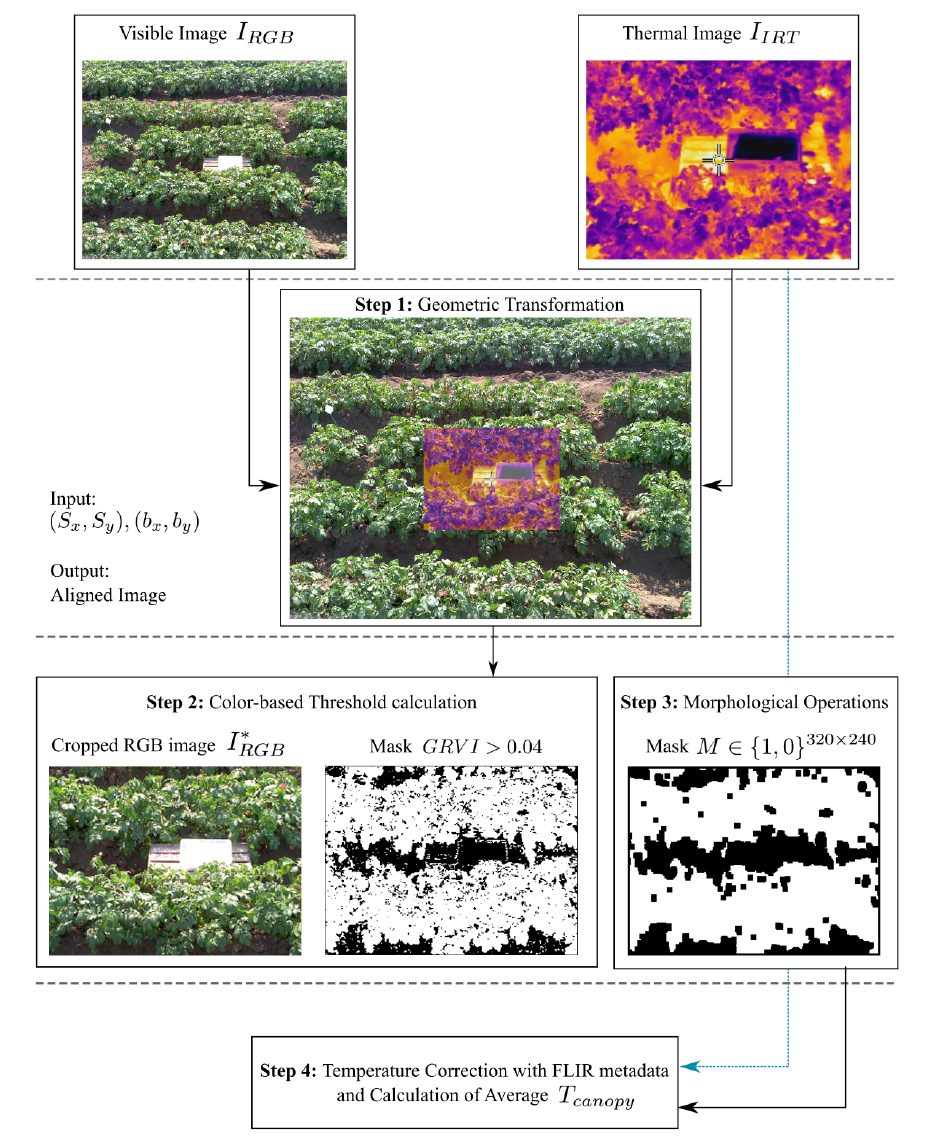
Figure 2. Automatic canopy average temperature algorithm flowchart. The IRT image is presented in a false color pattern for better visualization. Images are not presented in real